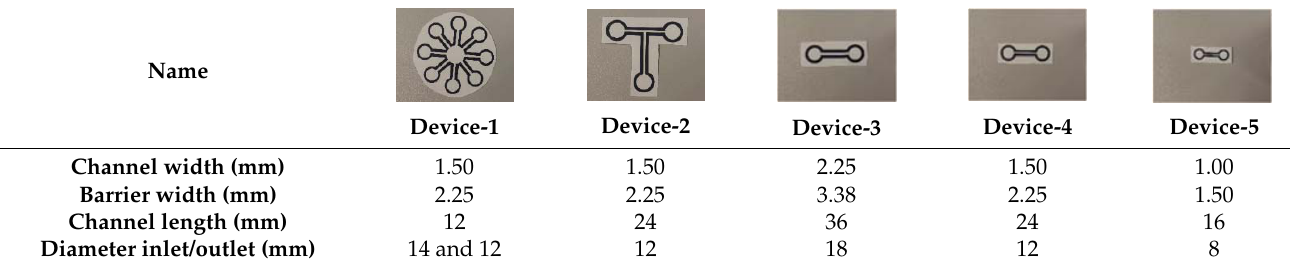
Table 1. Design specifications of the microfluidic paper-based analytical devices ( µ PADs) and picture, n = 3; error: ± 0.05. Name